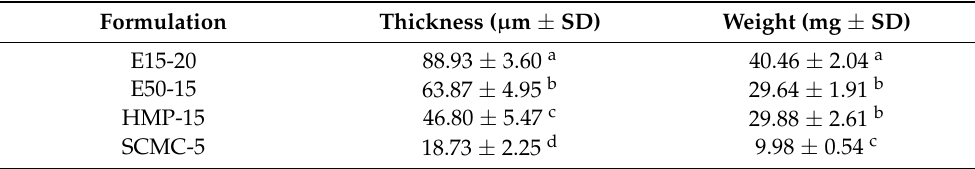
Table 4. Weight and thickness of 3D-printed